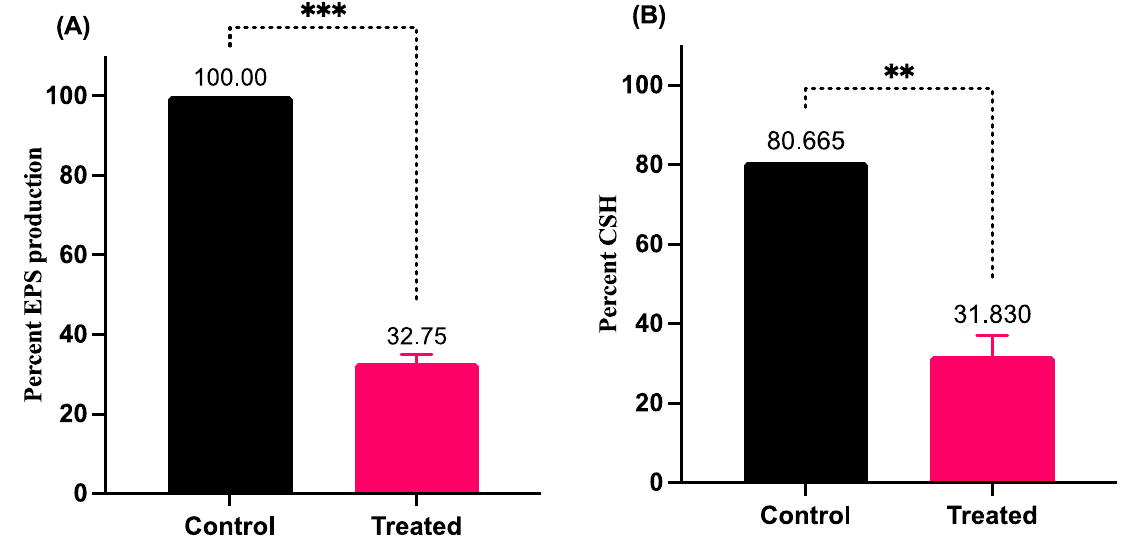
Figure 5. Effect of LME on EPS production and cell surface hydrophobicity (CSH). The figure demonstrates the modulation of EPS production (*** p value = 0.0005) and CSH (** p value = 0.0056) in the presence (treated) and absence (control) of LME.